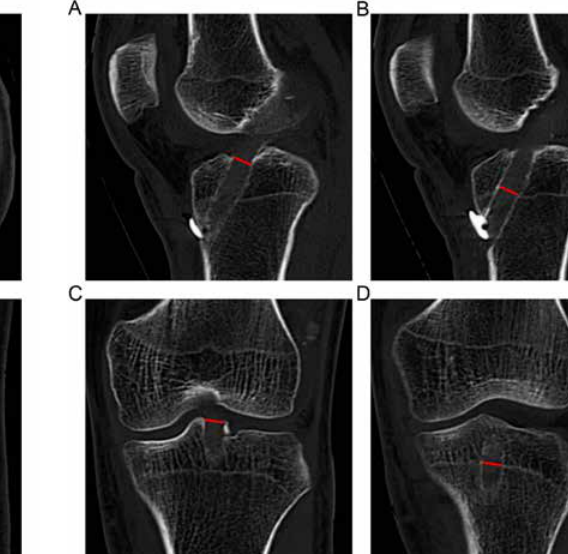
Figure 4: The measurement of the tibial tunnel diameter. (A): Plateau on the sagittal section (TS 1); (B): Middle on the sagittal section (TS 2); (C): Plateau on the coronal section (TC 1); (D): Middle on the coronal section (TC